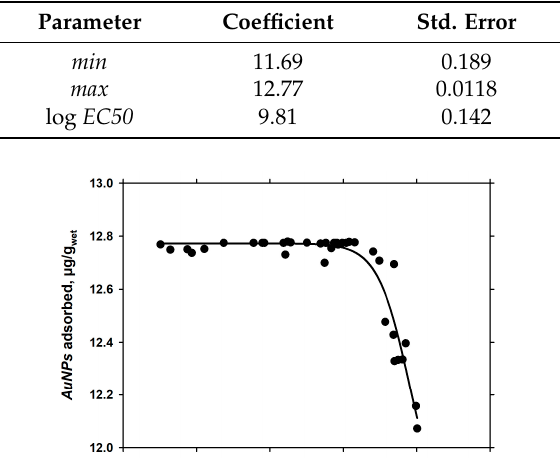
Table 2. The model fit parameters of Equation (1) of AuNPs adsorption onto diatoms. Parameter Coefficient Std. Error